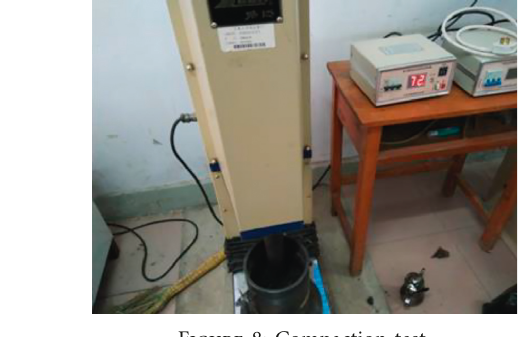
Figure 8: Compaction test.